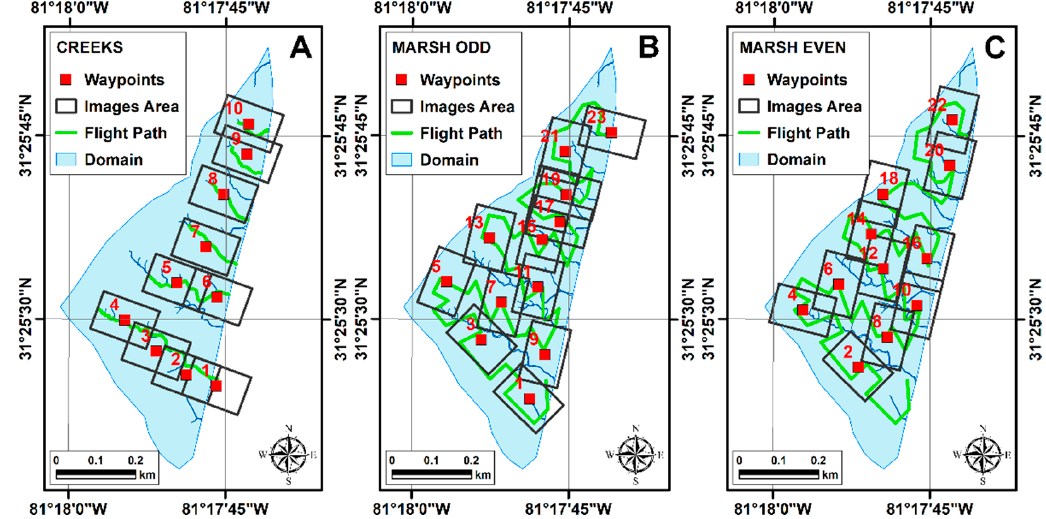
Figure 5. Flight paths of the drone releasing the dye (green lines) and image footprints for the high-altitude drone at each waypoint (black squares) in ( A ) the tidal channels; ( B ) the marshes (odd waypoints); ( C ) the marshes (even waypoints). Odd and even waypoints have been plotted separated for clarity. Table 3. Flight details for the second UAV, which collected RGB images over marshes, creeks, and main channel.